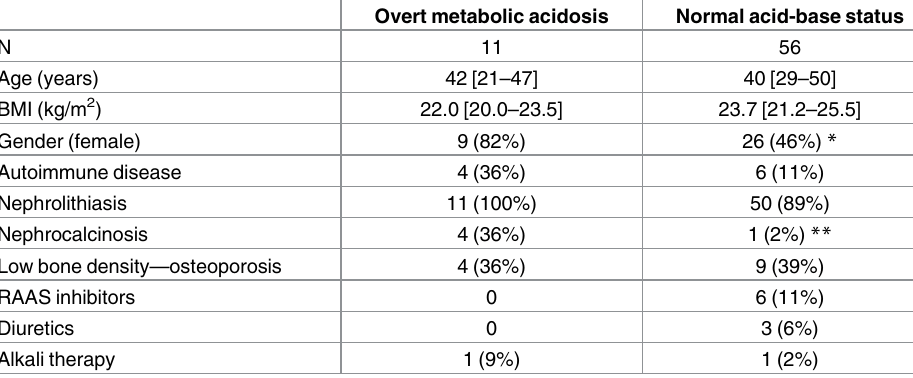
Table 1. Demographic and medical characteristics of the patients. Overt metabolic acidosis